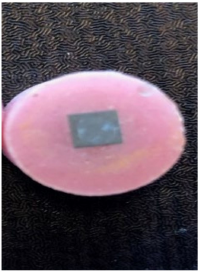
Figure 1. The sample after sandblasting